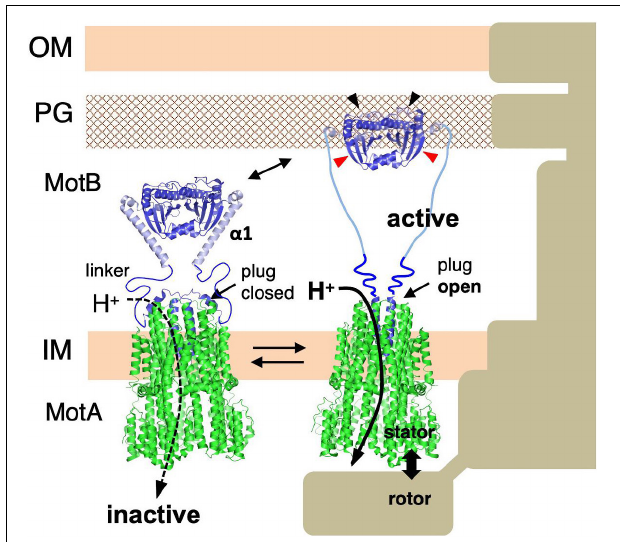
FIGURE 5 | Molecular model of stator activation. In the MotB protein, the crystallized MotB C region (PDB: 2ZVY) was directly connected to the transmembrane segment by way of the linker region and plug regions. A conformational change must be induced in MotB to enable it to reach the PG layer (black arrows). The structures of the flagellar stator (PDB: 6YKM) and the periplasmic fragments (MotB C ) of Salmonella MotB (PDB: 2ZVY) shown by a ribbon diagram are connected with a linker (left image). The structures of the unplugged stator (PDB: 6YKP) and the periplasmic fragments (MotB C ) of Salmonella MotB L119P mutant (PDB: 5Y40) are shown by a ribbon diagram are connected by the linker and the disordered helix α 1 region (right image). OM, outer membrane; IM, inner membrane; PG, peptidoglycan